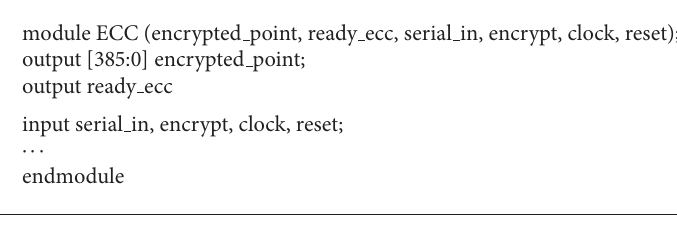
Algorithm 2: Verilog description of the elliptic curve cryptoengine.